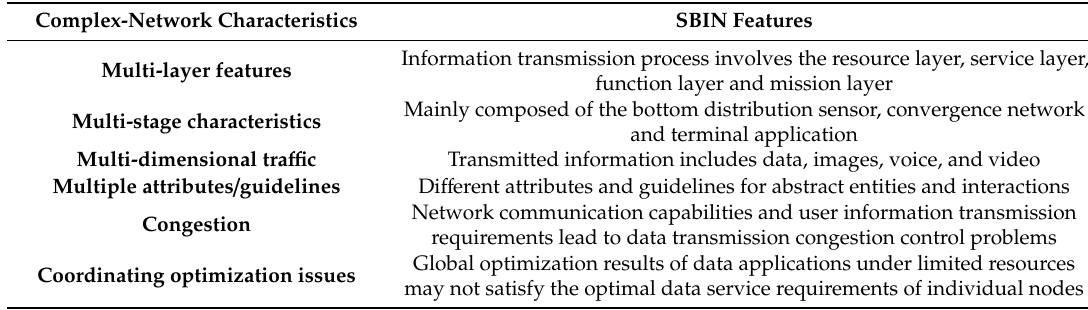
Table 1. Characteristics analysis of the space-based information network.